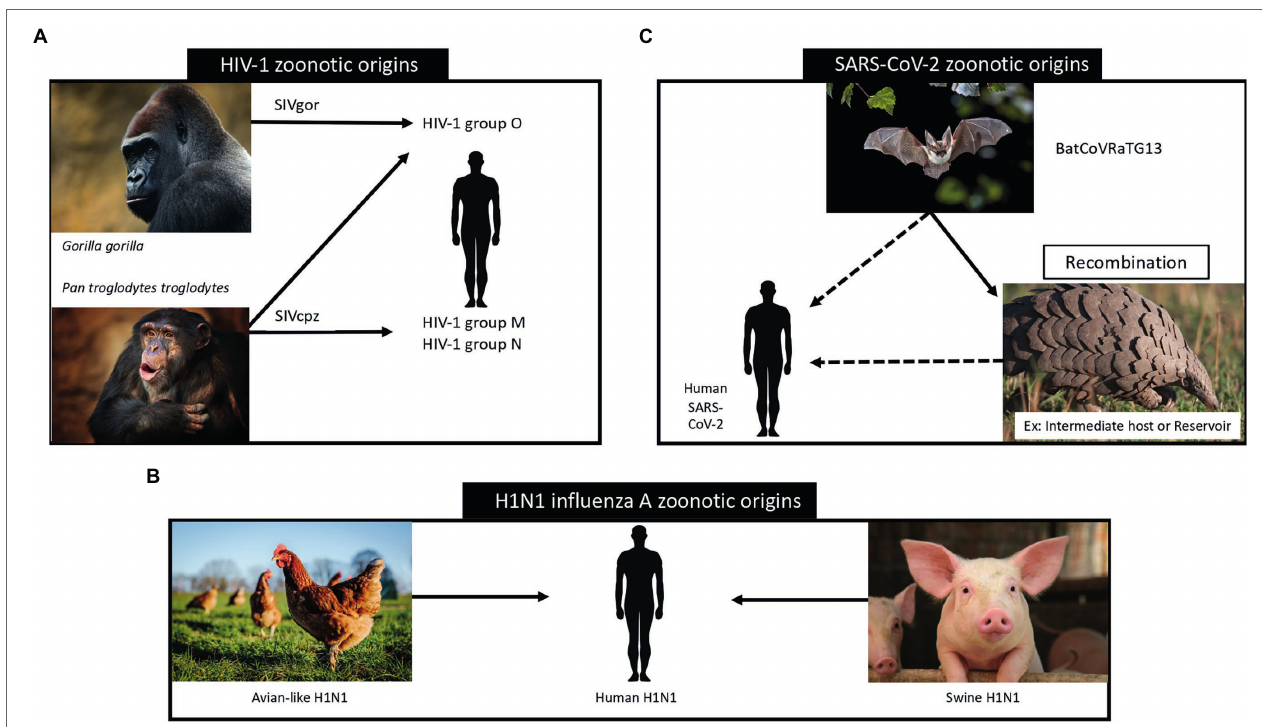
FIGURE 3 | Zoonotic origins of HIV-1 (panel A ; Tebit and Arts, 2011), influenza (panel B ; Taubenberger and Morens, 2006) and SARS-CoV-2 (panel C ; Konda et al., 2020) viruses and their relation to human transmission. In panel A we show the zoonotic transmission of Simian immunodeficiency viruses (SIV) from non- human primates to humans, leading to the development of the human immunodeficiency virus. Panel B depicts the main zoonotic origins of influenza A H1N1 viruses and their transmission to human hosts. In panel C we visualize the assumed zoonotic origin of SARS-CoV-2